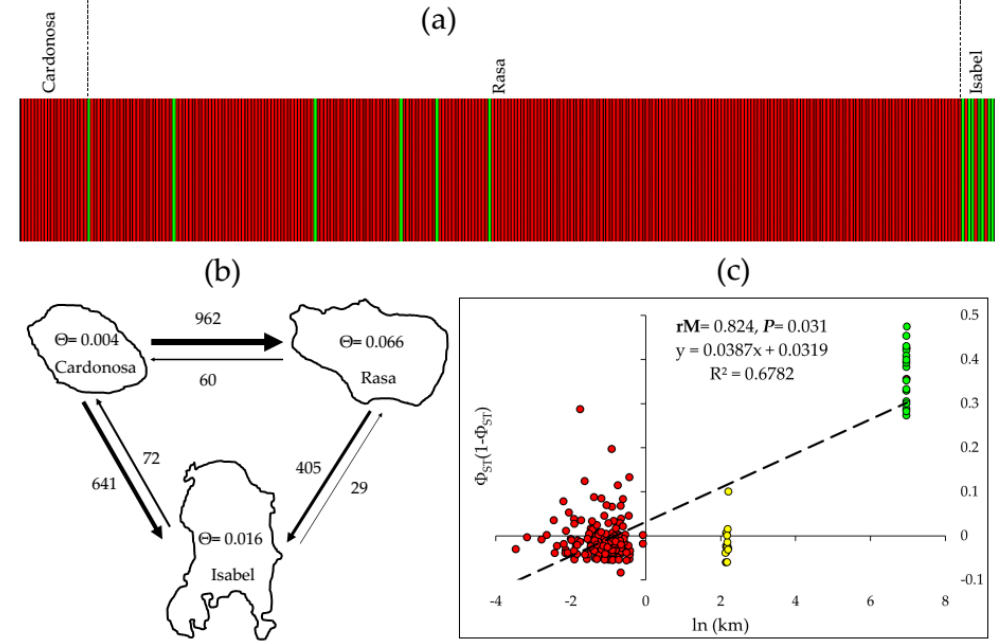
Figure 4. Genetic structure, scaled gene flow, and isolation by distance, calculated through 296 cytochrome b sequences of Heermann’s Gull. ( a ) Two clusters were inferred by the Bayesian approach BAPS ( K = 2). An individual’s probability of belonging to one of the clusters is represented by dif- ferent colors. ( b ) Estimates of gene flow obtained by MIGRATE. The effective population size ( Θ ) is shown within each island, while the scaled migration rate (M) is reported next to arrows showing the direction of migration. ( c ) Correlation plot among geographic (ln km) and genetic ( Φ ST /1 − Φ ST ) distances according to Rousset [89]. Association (rM) and probability ( p ) values of the Mantel test [88], along with the equation and Pearson coefficient (R 2 ), are shown. A positive correlation among pairwise comparisons from Cardonosa (yellow), Rasa (red), and Isabel (green) is observed. 3.5. Estimation of Gene Flow between Islands The estimated effective population size was lower for Cardonosa ( Θ = 0.004; 95% CI = 0.004–0.007) than for Rasa ( Θ = 0.066; 95% CI = 0.063–0.083) and Isabel Island ( Θ = 0.016; 95% CI = 0.005–0.024) (Figure 4b). The scaled gene flow was mostly non-symmetrical among islands. For example, higher migration was observed from Cardonosa to Rasa